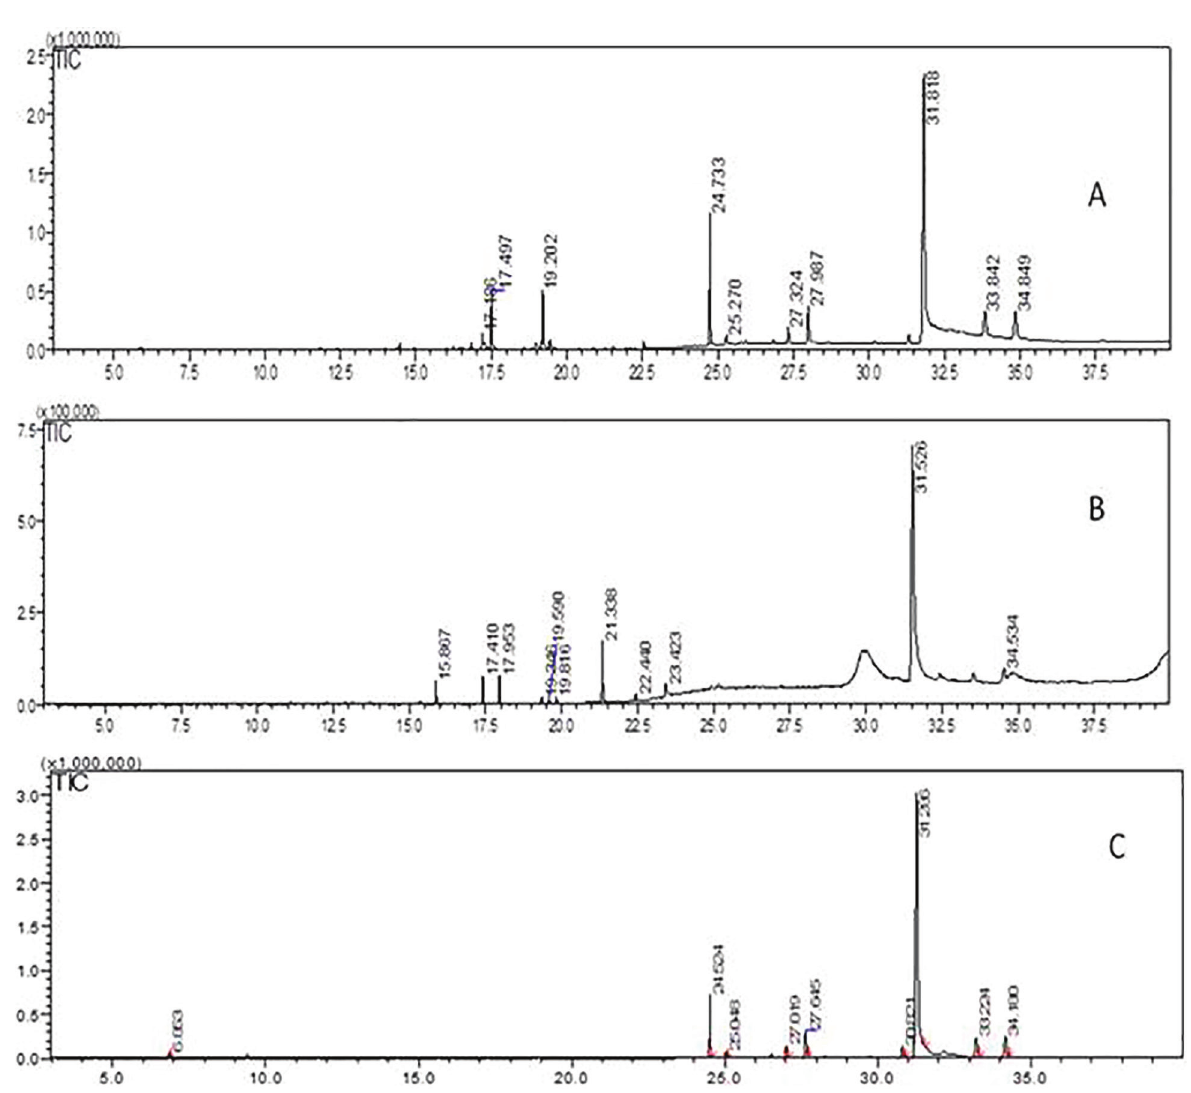
FIGURE 4 - GC-MS chromatogram profiles of the fractions from the liquid-liquid partition: hexane (HP) (A), dichloromethane (DP) (B) and the extract from Soxhlet: hexane (HSox) (C).